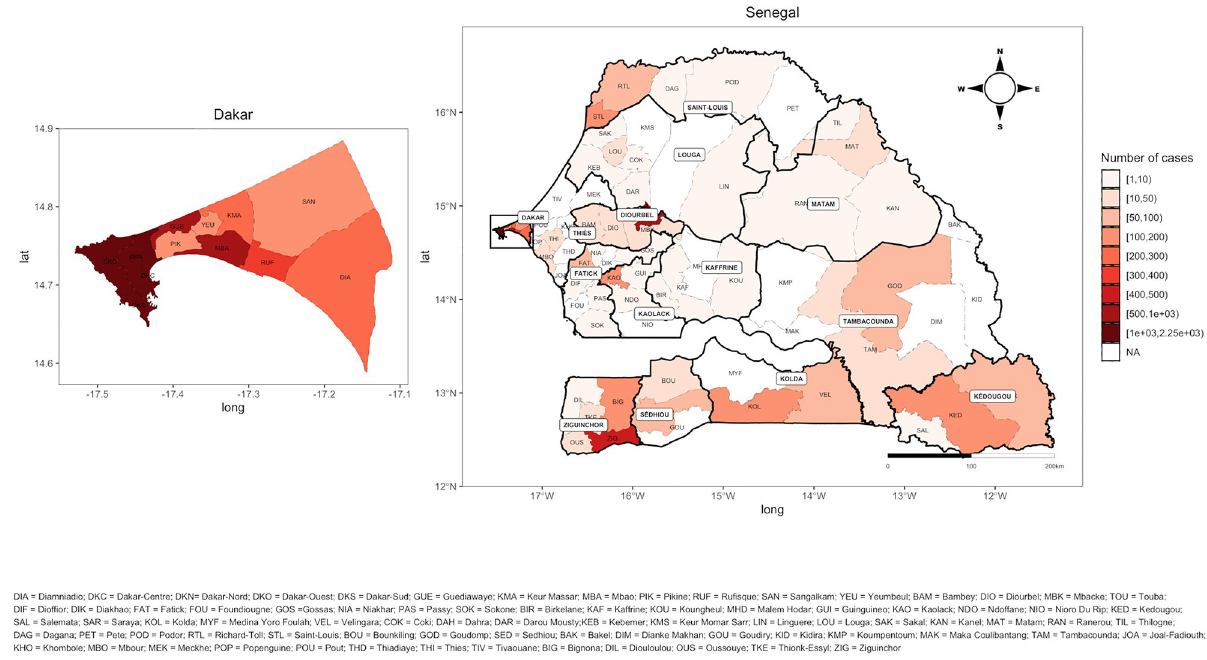
Fig 4. Spatial distribution of COVID-19 positive cases at district